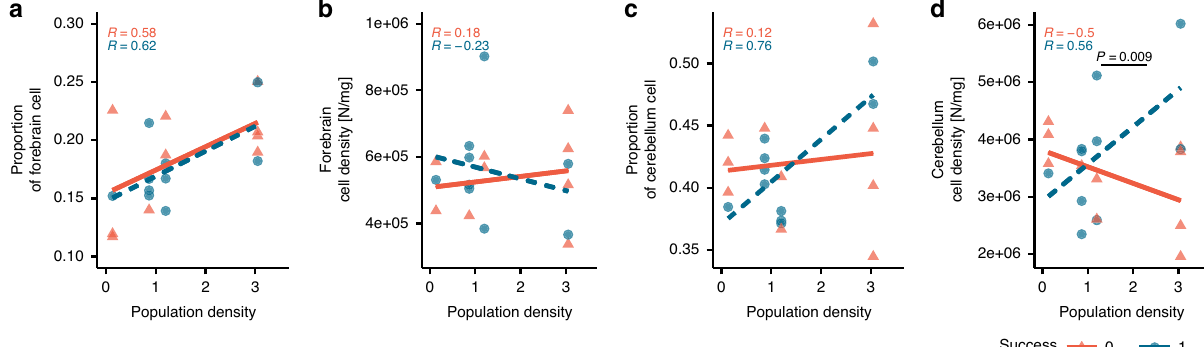
Fig. 3 Relationship between performance, forebrain and cerebellum cell count measurements, and population density. Scatterplots of a forebrain cell proportion from the total brain cell count, b forebrain cell density, c cerebellum cell proportion from the total brain cell count, and d cerebellum cell density. The p- value indicates signi fi cant ( p < 0.05, GLMs) interaction between cerebellum density and cleaner population. R coef fi cient refers to the Pearson correlation coef fi cient. Red triangles refer to failure while blue circles refer to success in the biological market task. Sample size in a , c and d is n = 20 biologically independent animals. In b , there is n = 18 biologically independent animals.